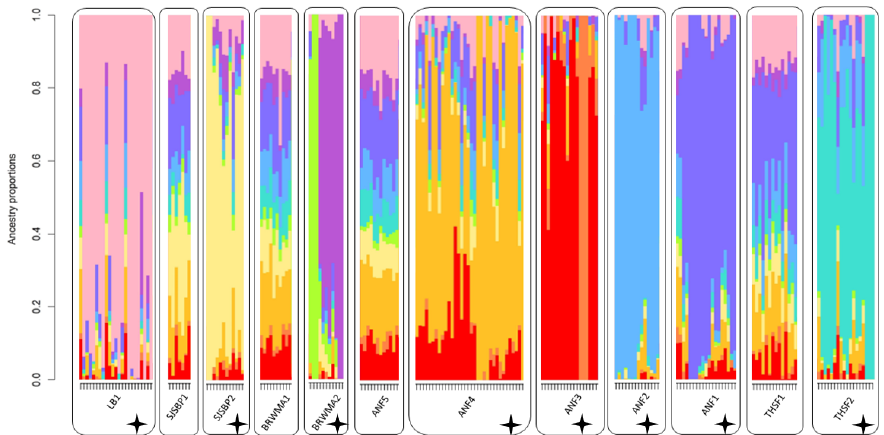
Our analysis of ancestry proportions identified ten ancestral populations (K = 10) as the most likely scenario. Lathrop Bayou, SJSBP2, BRWMA2, ANF1, ANF2, ANF3, ANF4, and THSF2 all contained individuals possessing unique ancestry proportions that were not present in any other population. The four remaining populations (ANF5, SJSBP1, BRWMA1, and THSF1) were almost entirely composed of individuals with highly admixed ancestry estimates and did not display an identifiably unique pattern of ancestry (Figure 5).